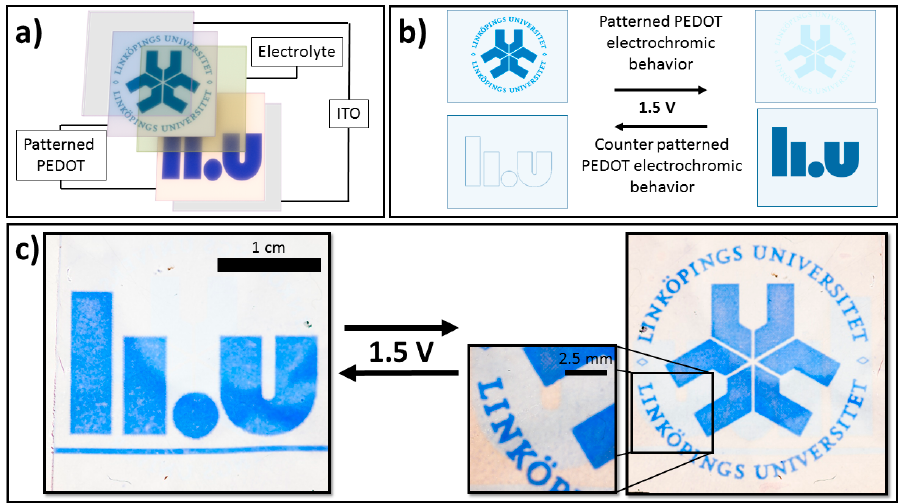
Figure 1. ( a ) Picture-to-picture electrochromic device architecture based on two patterned poly(3,4-ethylenedioxythiophene with tosylate (PEDOT:Tos) layers separated by a transparent electrolyte. ( b ) Schematic illustration of the individual electrochromic behavior of the two patterned PEDOT layers when voltages of 1.5 V were applied in the forward and reverse bias. The images appeared and disappeared in opposite voltage directions, allowing for a picture-to-picture device. ( c ) Photographs of the same picture-to-picture electrochromic device in both states, showing clearly the new (left) and old (right) Linköping University logos. The device can be seen switching in real time in SIMovie1. The thickness of the PEDOT:Tos layers were approximately 200 nm for the pristine regions and approximately 350 nm for the ultraviolet (UV)-exposed